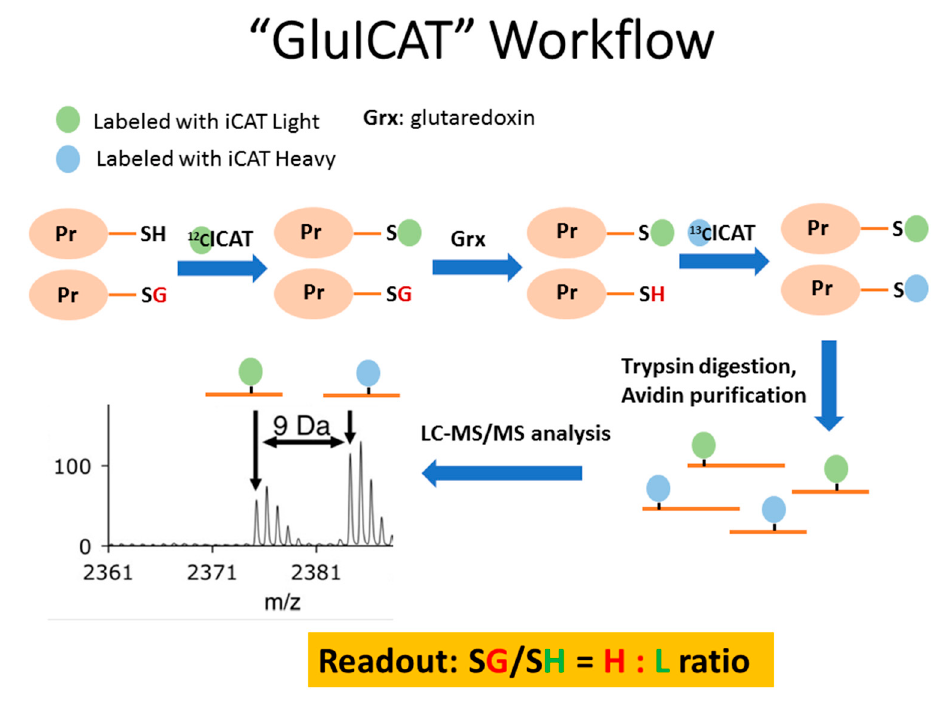
Figure 4. Workflow for quantitative analysis of proteome-wide glutathionylation using our previously developed strategy (GluICAT) [17]. Reduced thiols are labeled with light ICAT ( 12 C). Glutathionylated thiols were specifically cleaved using glutaredoxin (Grx) and subsequently labeled with heavy ICAT ( 13 C). After tryptic digestion and avidin enrichment, peptides were analyzed using LC-MS / MS. The extent of glutathionylation (SG / SH) of a peptide can be determined by the ratio of heavy-to-light ICATs (H:L).